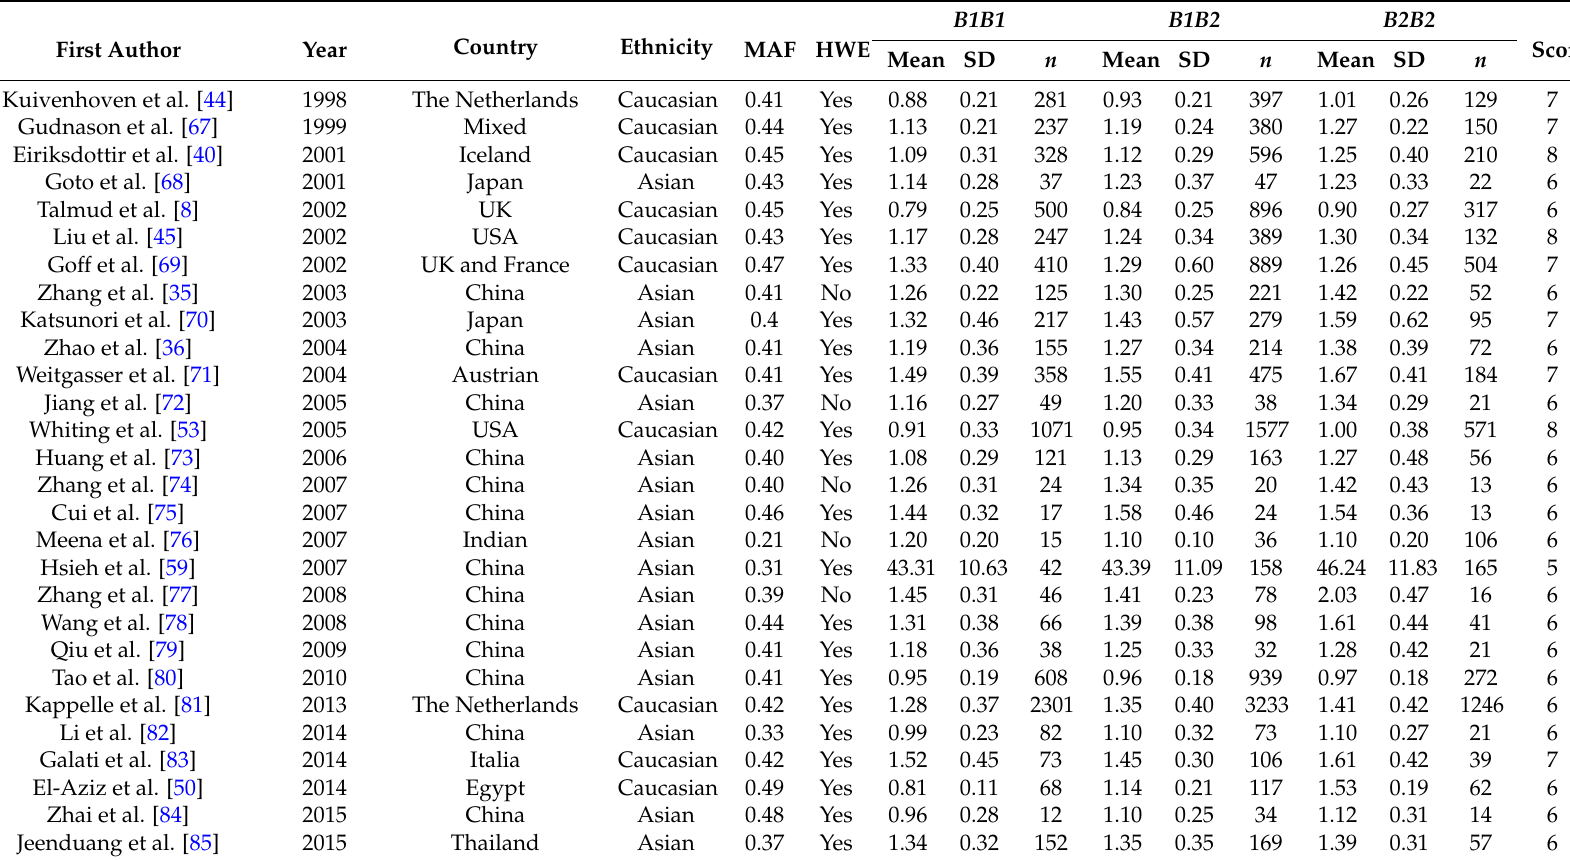
Table 2. Characteristics of individual studies included in the meta-analysis of HDL-C level and the CETP TaqIB